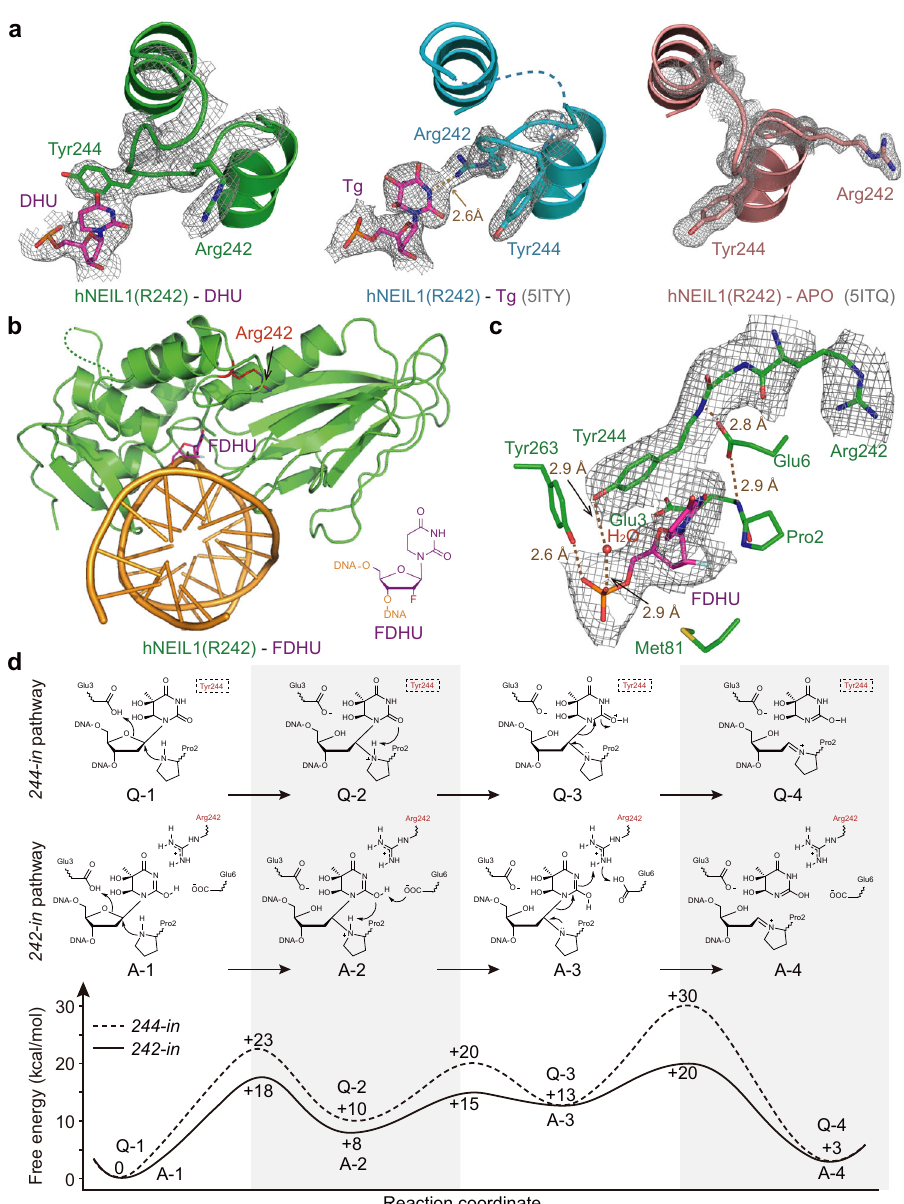
Fig. 2 Characterization of a newfound hNEIL1 – DNA interaction mode. a Crystal structure of hNEIL1(R242) bound to DHU (left) reveals a distinct conformation of lesion recognition loop, compared with the hNEIL1(R242)-Tg structure (middle) or the hNEIL1(R242)-APO structure (right). In the DHU- bound structure, Arg242 occupies the same position which is originally taken by Tyr244 of the Tg-containing structure, while Tyr244 stacks against the fl ipped DHU base. In addition, Arg242 of the APO structure is placed far away from the damaged bases and fully exposed to the solvent. The gray 2Fo − Fc simulated-annealing composite omit electron density map is contoured at 1.0 σ for both damaged bases and lesion recognition loop. b Overall structure of hNEIL1(R242) bound to dsDNA-containing FDHU. The chemical structure of FDHU deoxynucleotide is shown in purple and residue 242 is colored in red. c Zoom-in view of the interactions between hNEIL1(R242) and FDHU. The brown dashed lines represent hydrogen bond interactions and red ball stands for water molecules. d QM/MM calculations reveal that the free-energy pro fi le of base cleavage reaction pathway for 244-in conformation displays an extremely high energy barrier, comparing to a more reasonable 242-in